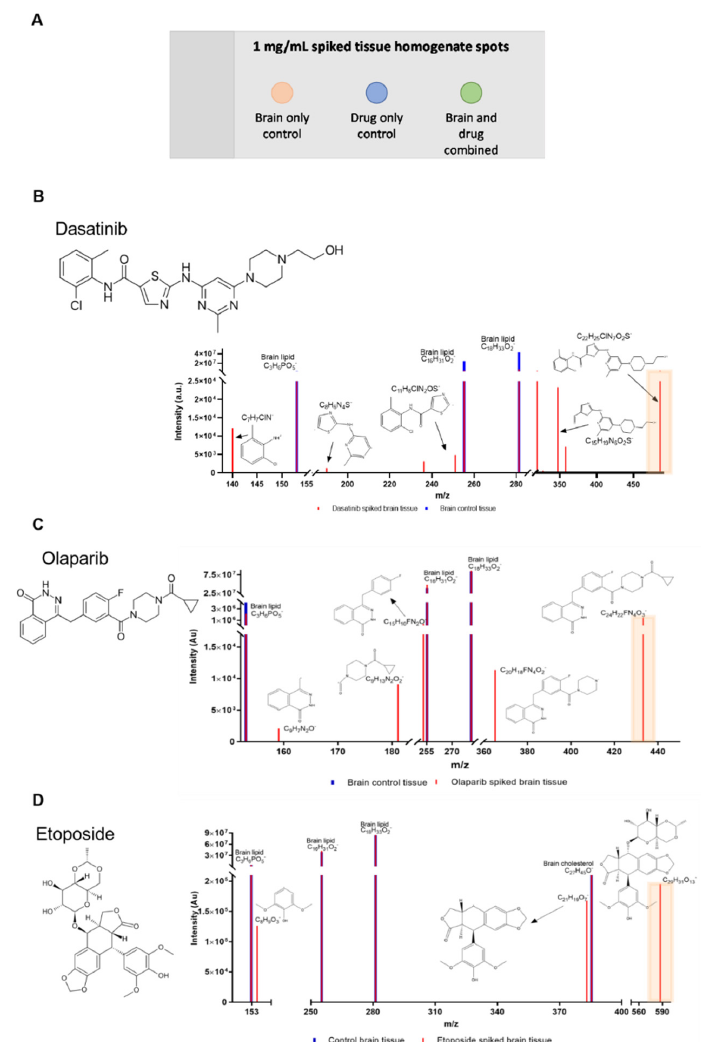
Figure 1. Schematic depicting 3D OrbiSIMS set-up. An ion beam is applied to the surface of a sample, whereby surface molecules are fragmented and ionised. These ions are separated either by time-of-flight or an Orbitrap analyser, following which they are detected to an accuracy of <2 ppm. In our case, the Orbitrap analyser with a mass resolution of 240,000 at m / z 200 was employed to analyse ions fragmented using a 20 KeV Ar 3000+ ion beam. Samples were analysed using mode 4 and 7 of the instrumentation, as published by Passarelli et al. [11].